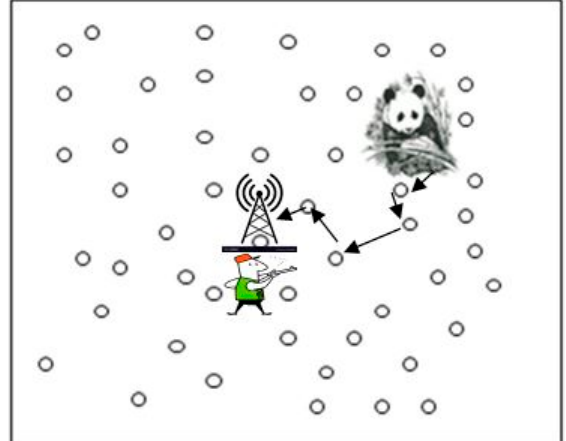
Figure 3. Panda Hunter Game Model.